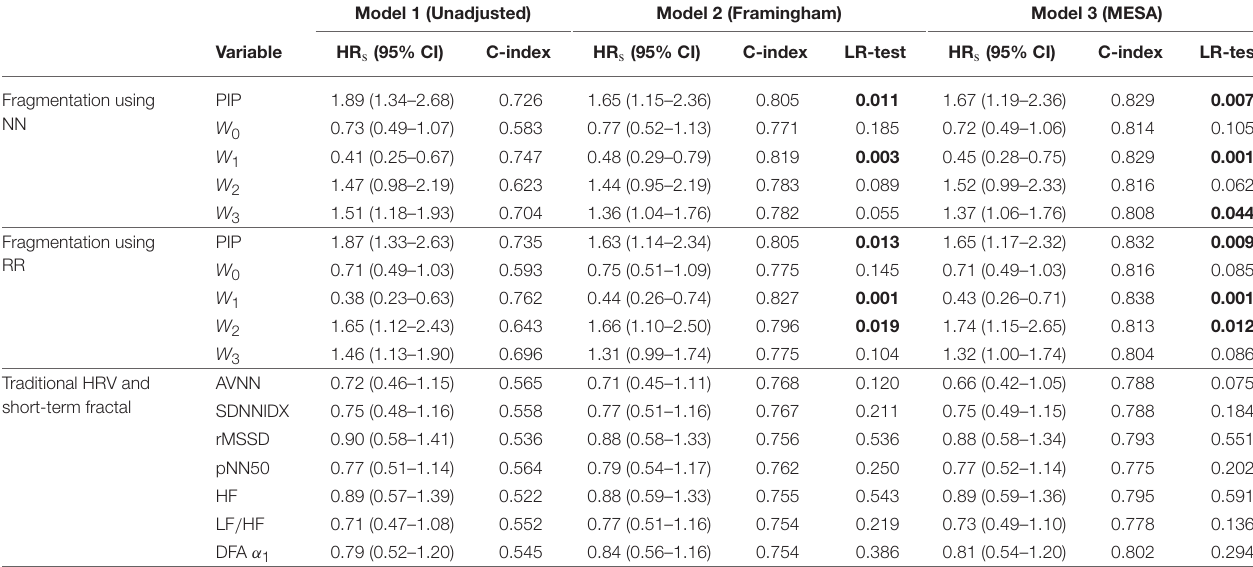
TABLE 4 | Association of fragmentation, traditional HRV and short-term fractal indices with CV death in models adjusted for the Framingham and MESA CV risk indices.